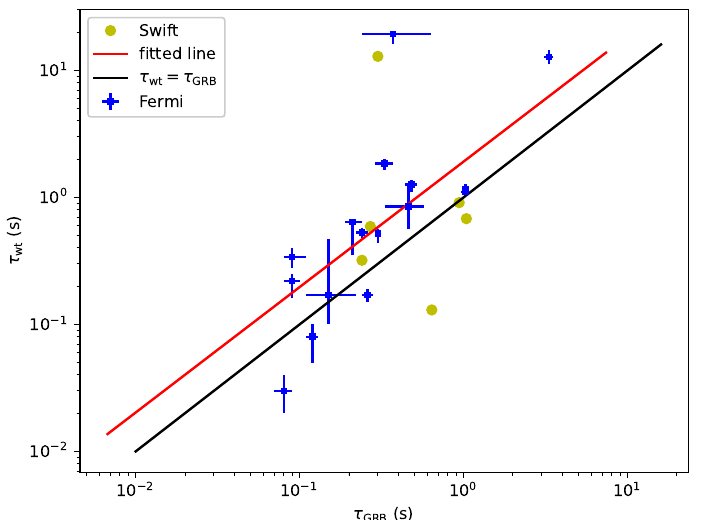
Figure 2. The waiting time and GRB duration are taken from [69] for Fermi detected bursts, and from [40,79] for Swift detected bursts. The black is the τ wt = τ GRB line, and the red line is the fitting of the